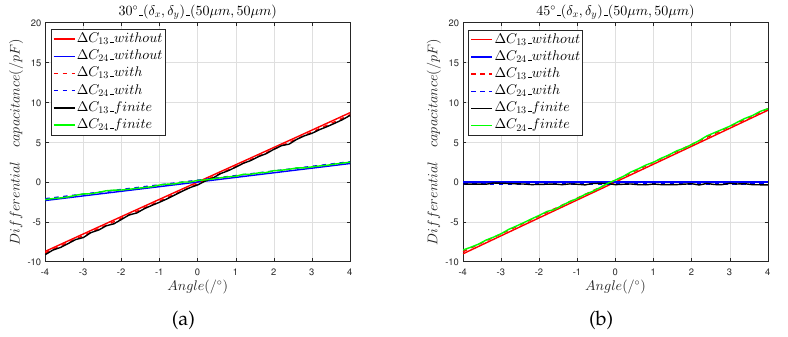
Figure 5. The 50 µ m axial installation error analysis: ( a ) differential capacitance in the 30° direction; ( b ) output capacitance in the 45°